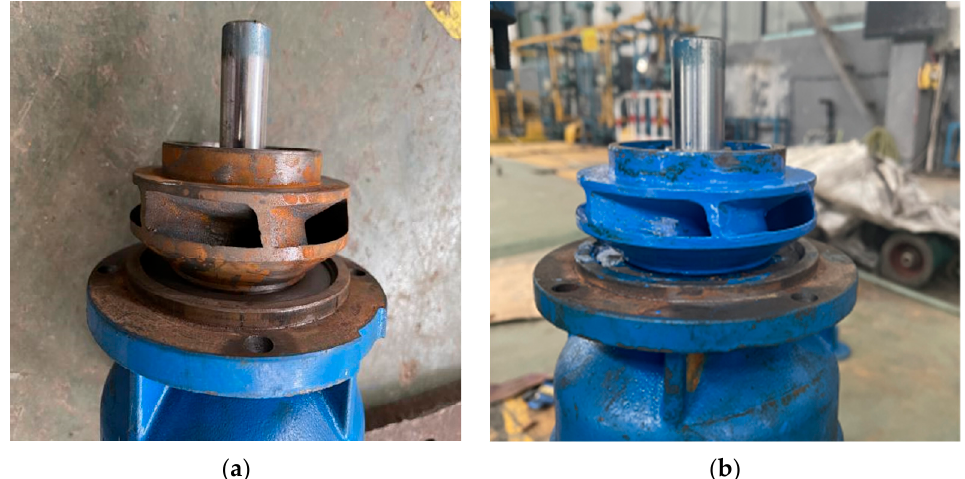
Figure 28. Comparison diagram of impeller runner before and after applying water-based paint: ( a ) before painting; ( b ) after painting. During the erosion test under 13 m 3 /h, 20 m 3 /h, and 26 m 3 /h flow conditions, the site is shown in Figure 29.